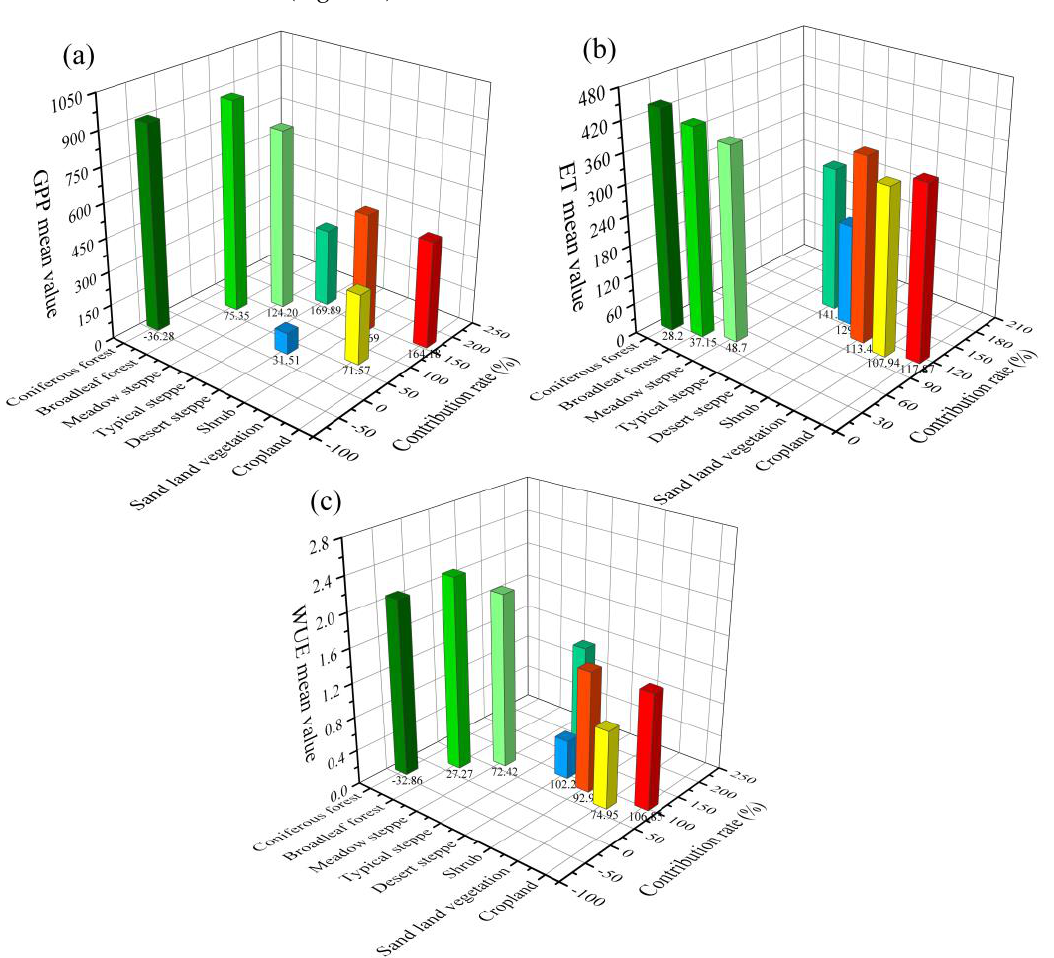
Figure 5. The mean values of each vegetation type and their contribution to ( a ) GPP, ( b ) ET, and ( c ) WUE IAV in Inner Mongolia from 2001 to 2020.